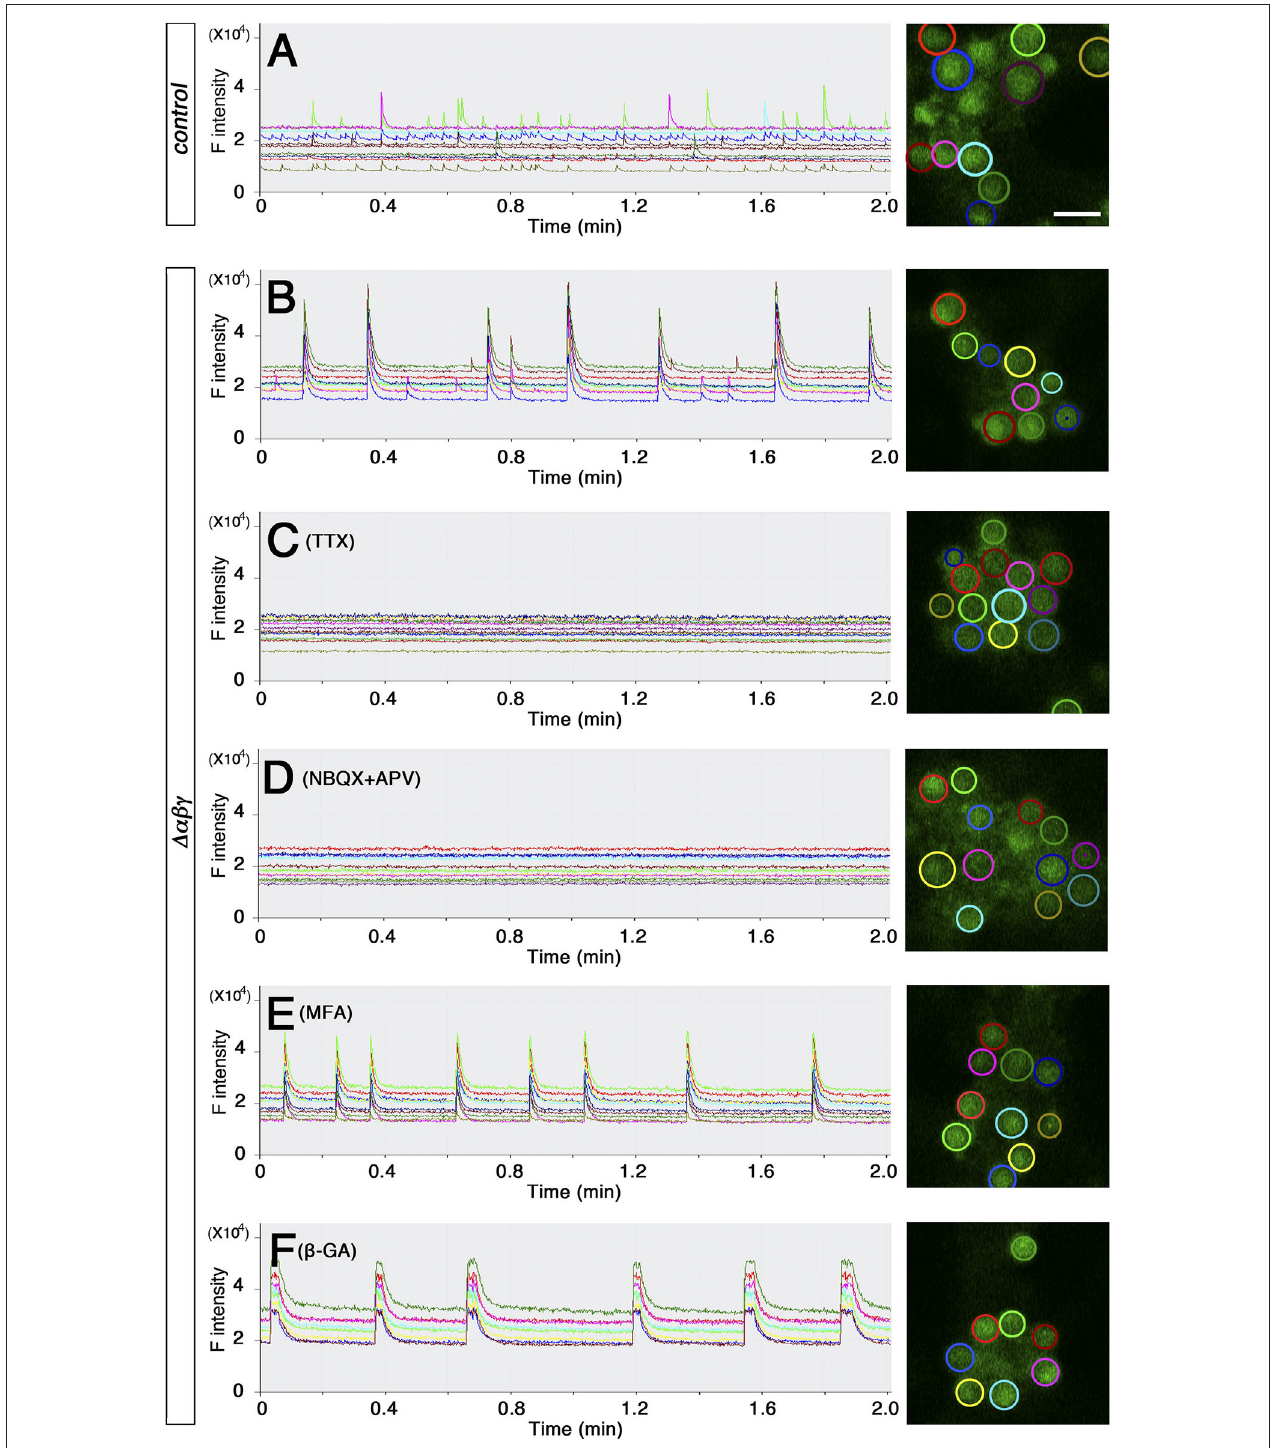
FIGURE 4 | Spontaneous activity in cultured hippocampal neurons (A,B) calcium response from DIV 20–21 cultured hippocampal neurons loaded with OGB-1AM. Neurons in the right panel are circled in colors that match the corresponding graph at left. (C–F) Effects of blockers on the synchronized rhythmic calcium response of ∆αβγ hippocampal neurons. Calcium responses were recorded at DIV23 (C) or DIV20 (D–F) . DIV23 cultures were recorded in regular aCSF, while the earlier DIV20 cultures were recorded in modified aCSF containing 3.3 mM KCl. (I–L) Examples of the calcium response after the application of 100 nM TTX (C) , 20 µ M NBQX, and 50 µ M APV (D) , 25 µ M MFA (meclofenamic acid) (E) , or 25 µ M β -GA (18 β -Glycyrrhetinic acid) (F) . All cultures were confirmed to exhibit a synchronized rhythmic calcium response before blocker application. Data derived from the Pcdh αβγ + / + :TG taf 7 and Pcdh αβγ del / + :TG taf 7 genotypes were used as controls. Bar: 20 µ